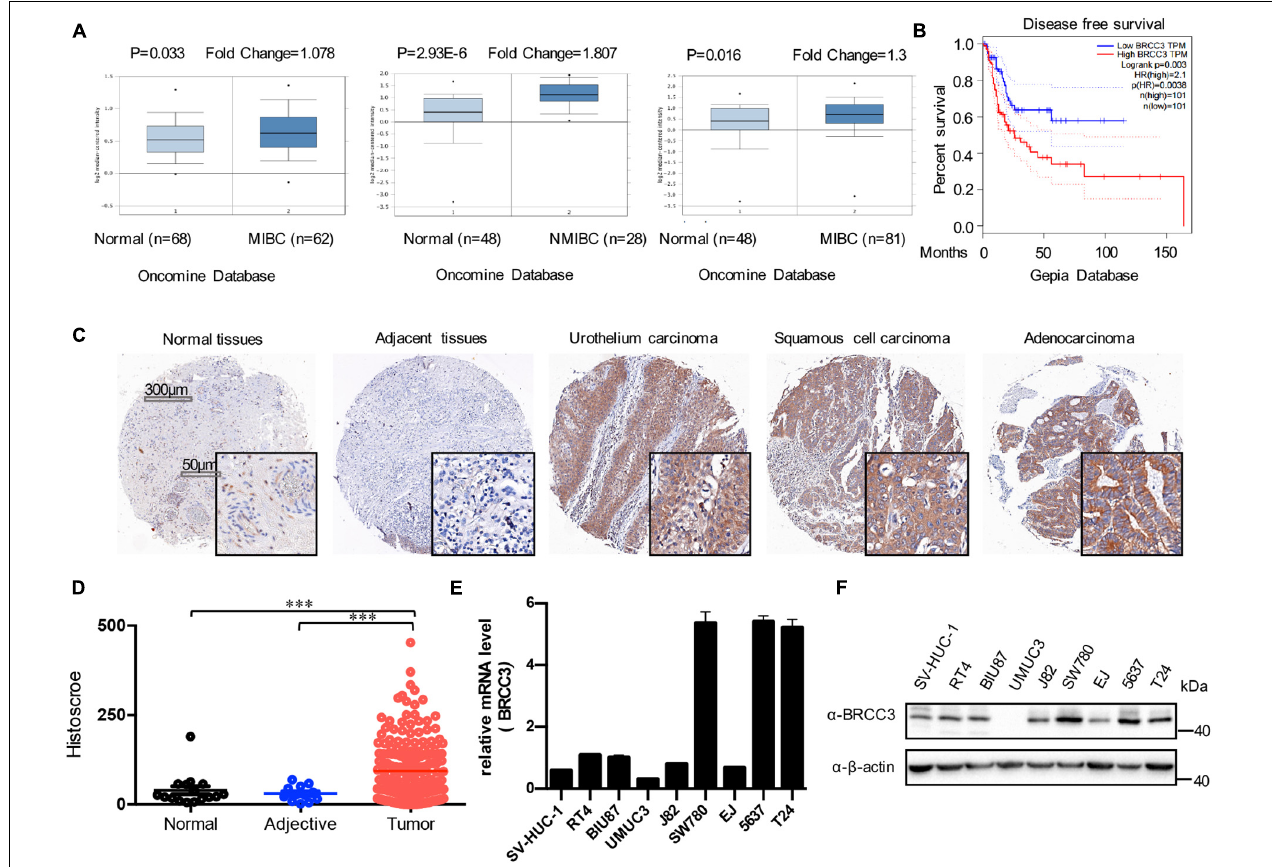
FIGURE 1 | Expression of BRCC3 in bladder cancer. (A) Data form Oncomine database. Three microarray datasets exhibited obvious upregulation of BRCC3 expression in muscle-invading bladder cancer tissue compared to normal. (B) Disease-free survival time analysis of data from the GEPIA database. The p -value is indicated. (C) Immunohistochemical staining for BRCC3 in tissue microarrays containing cancer tissue samples, adjacent tissue samples and normal bladder tissue samples from patients with chronic cystitis or a healthy urinary tract. Representative staining images for different pathological types of bladder cancer including uro-endothelial carcinoma, squamous cell carcinomas and adenocarcinoma are shown. (D) Tissue microarray data analysis of BRCC3 expression in 188 bladder cancer tissue samples, 12 corresponding adjacent tissue samples and 16 normal bladder tissue samples (including 8 chronic cystitis tissue samples and 8